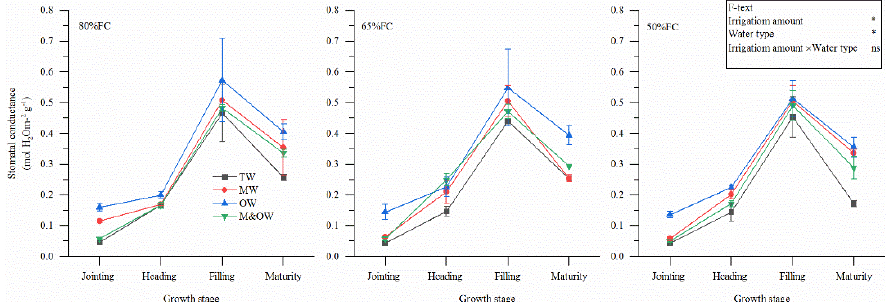
Figure 6. Effect of tap water (TW), magnetized water (MW), oxygenated water (OW), and magnetized and oxygenated water (M&OW) irrigation on net photosynthetic rate of winter wheat with 80%FC, 65%FC, and 50%FC irrigation amounts in the different growth stages. Irrigation amount × water type represents the effect of interaction between irrigation amount and water type. * and ** identify significant differences at p < 0.05 and p < 0.01, respectively, and ns identifies no significant differences. The error bars indicate standard deviations.